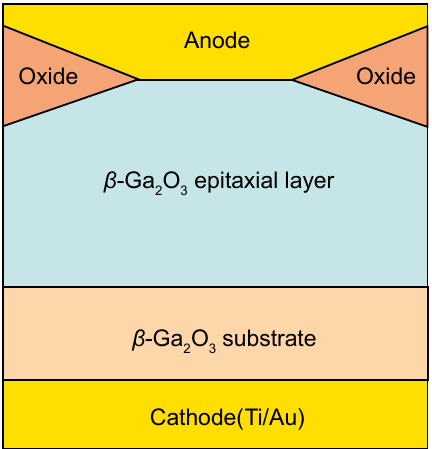
Figure 5. Device diagrams of SBD with beveled field plate.